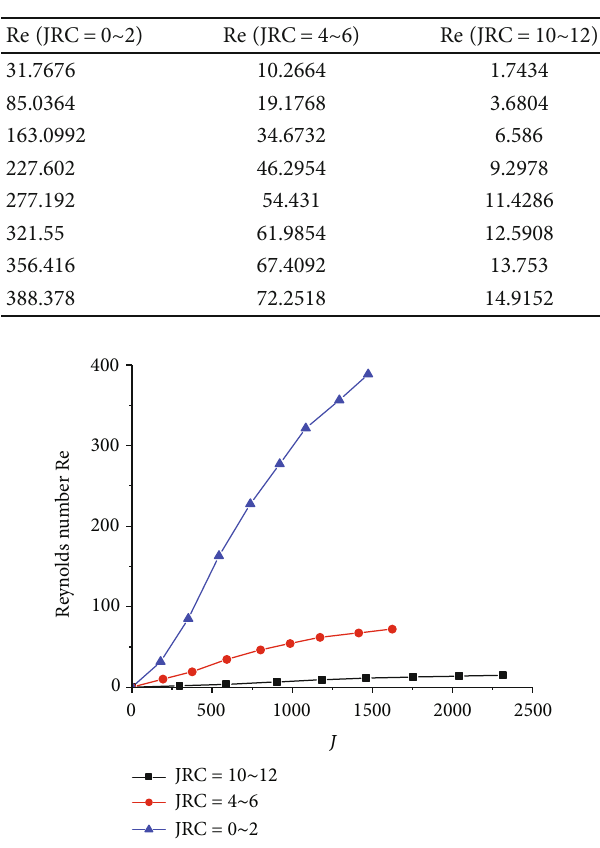
Table 4: Values of Reynolds number Re for all test cases.